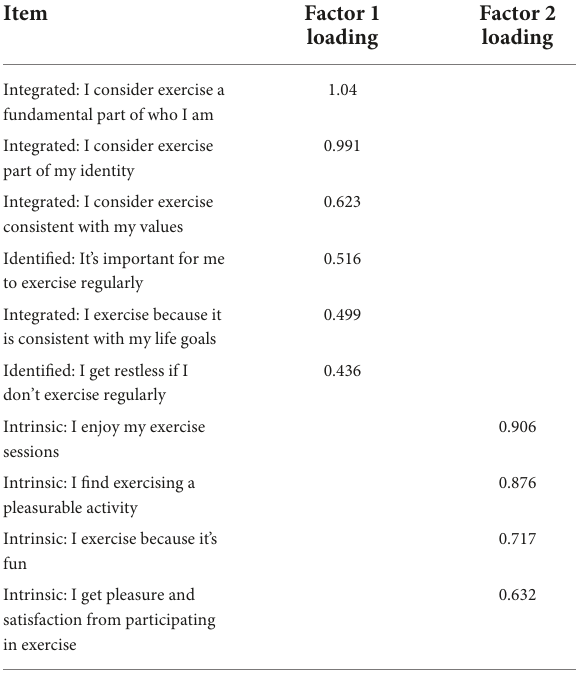
TABLE 2 Exploratory Factor Analysis (EFA) pattern